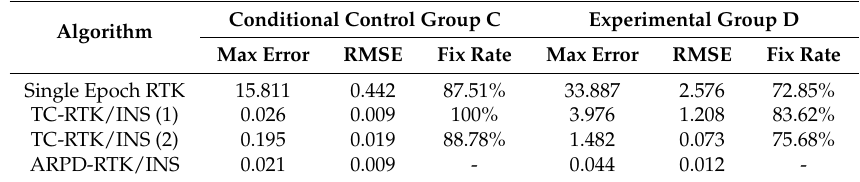
Figure 9. ( a ) Error distribution in ECEF-XY axis under Scene C; ( b ) Error distribution in ECEF-XY axis under Scene D. Table 3. Trajectory error and fix rate for different RTK algorithms with large pseudorange errors (Unit: